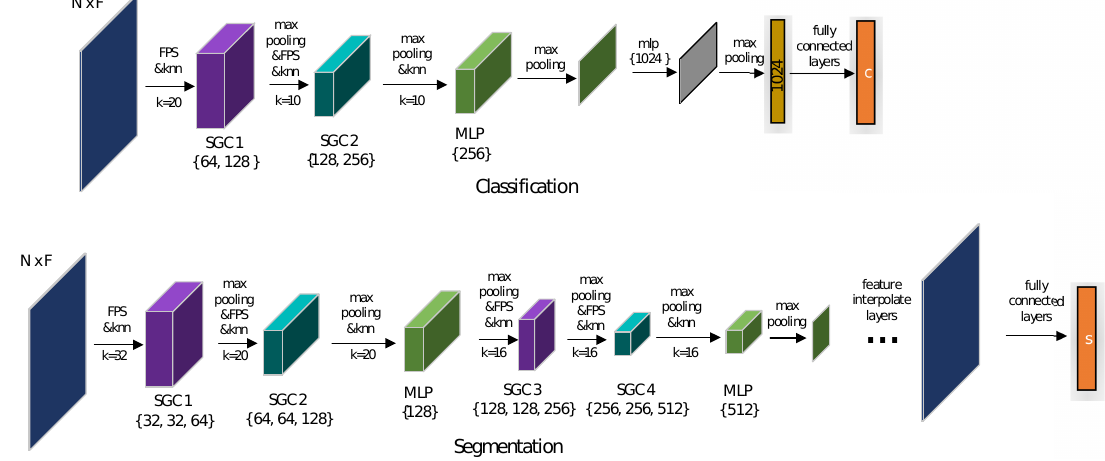
Figure 5. ShufflePointNet architecture: The architecture uses PointNet++ as backbone, and it contains classification structure (top branch) and semantic segmentation structure (bottom branch) for point cloud. In detail, N , F indicates the number of input points, and corresponding feature channels, respectively. k is the number of the neighbours. In addition, the number in the brace {} indicates the MLP filters. The classification model recursively applies Furthest Point Sampling (FPS) and a Shuffled Group Convolution (SGC) module to capture downsampled local features, followed by a shared full-connected layer to generate a global feature, which is used to predict classification